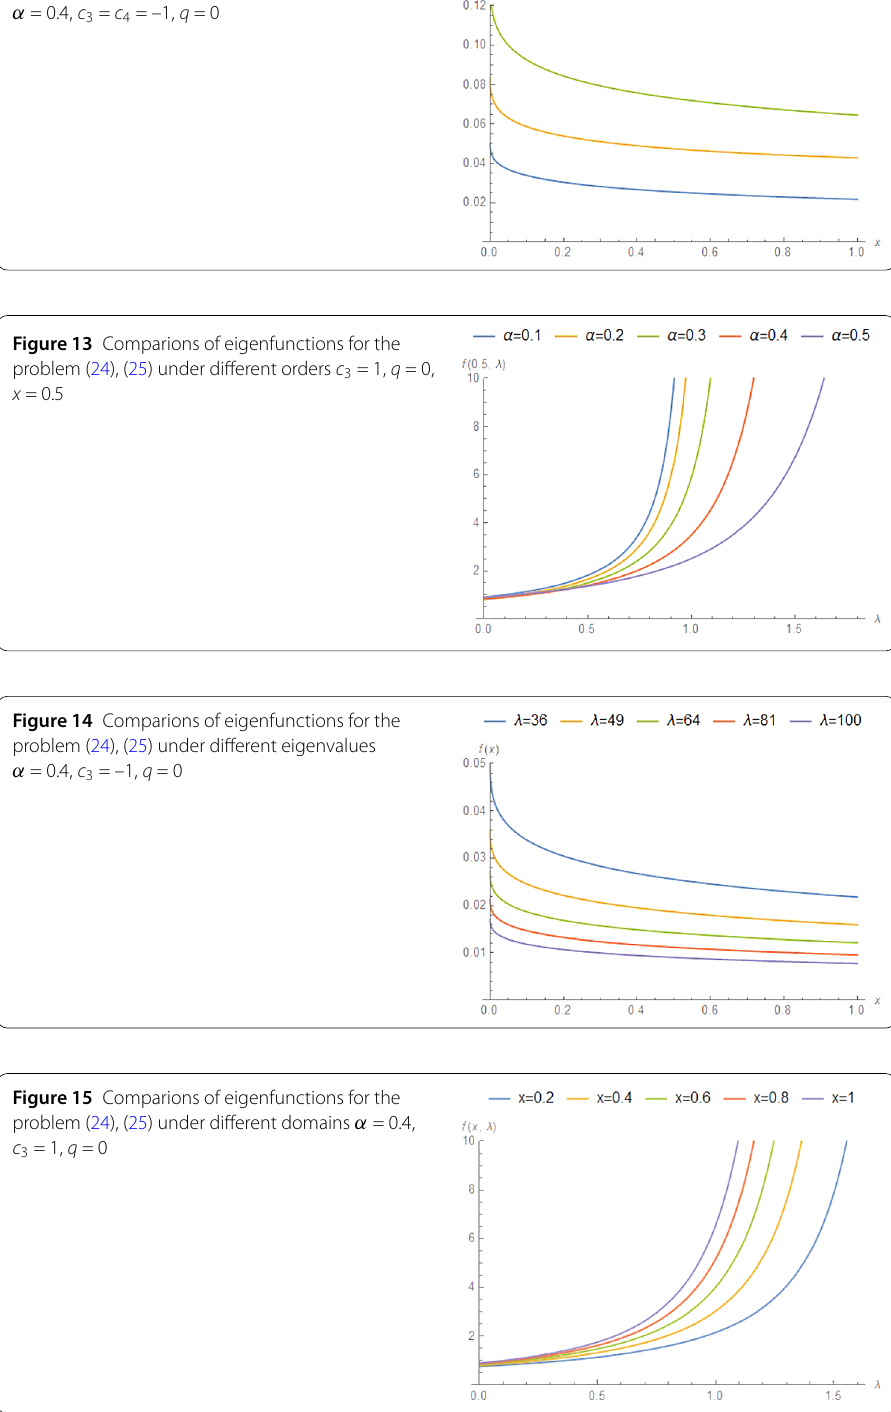
Figure 12 Comparions of eigenfunctions for the problem (30), (31)—(24), (25)—(27), (28) λ = 36, α = 0.4, c 3 = c 4 = –1, q = 0